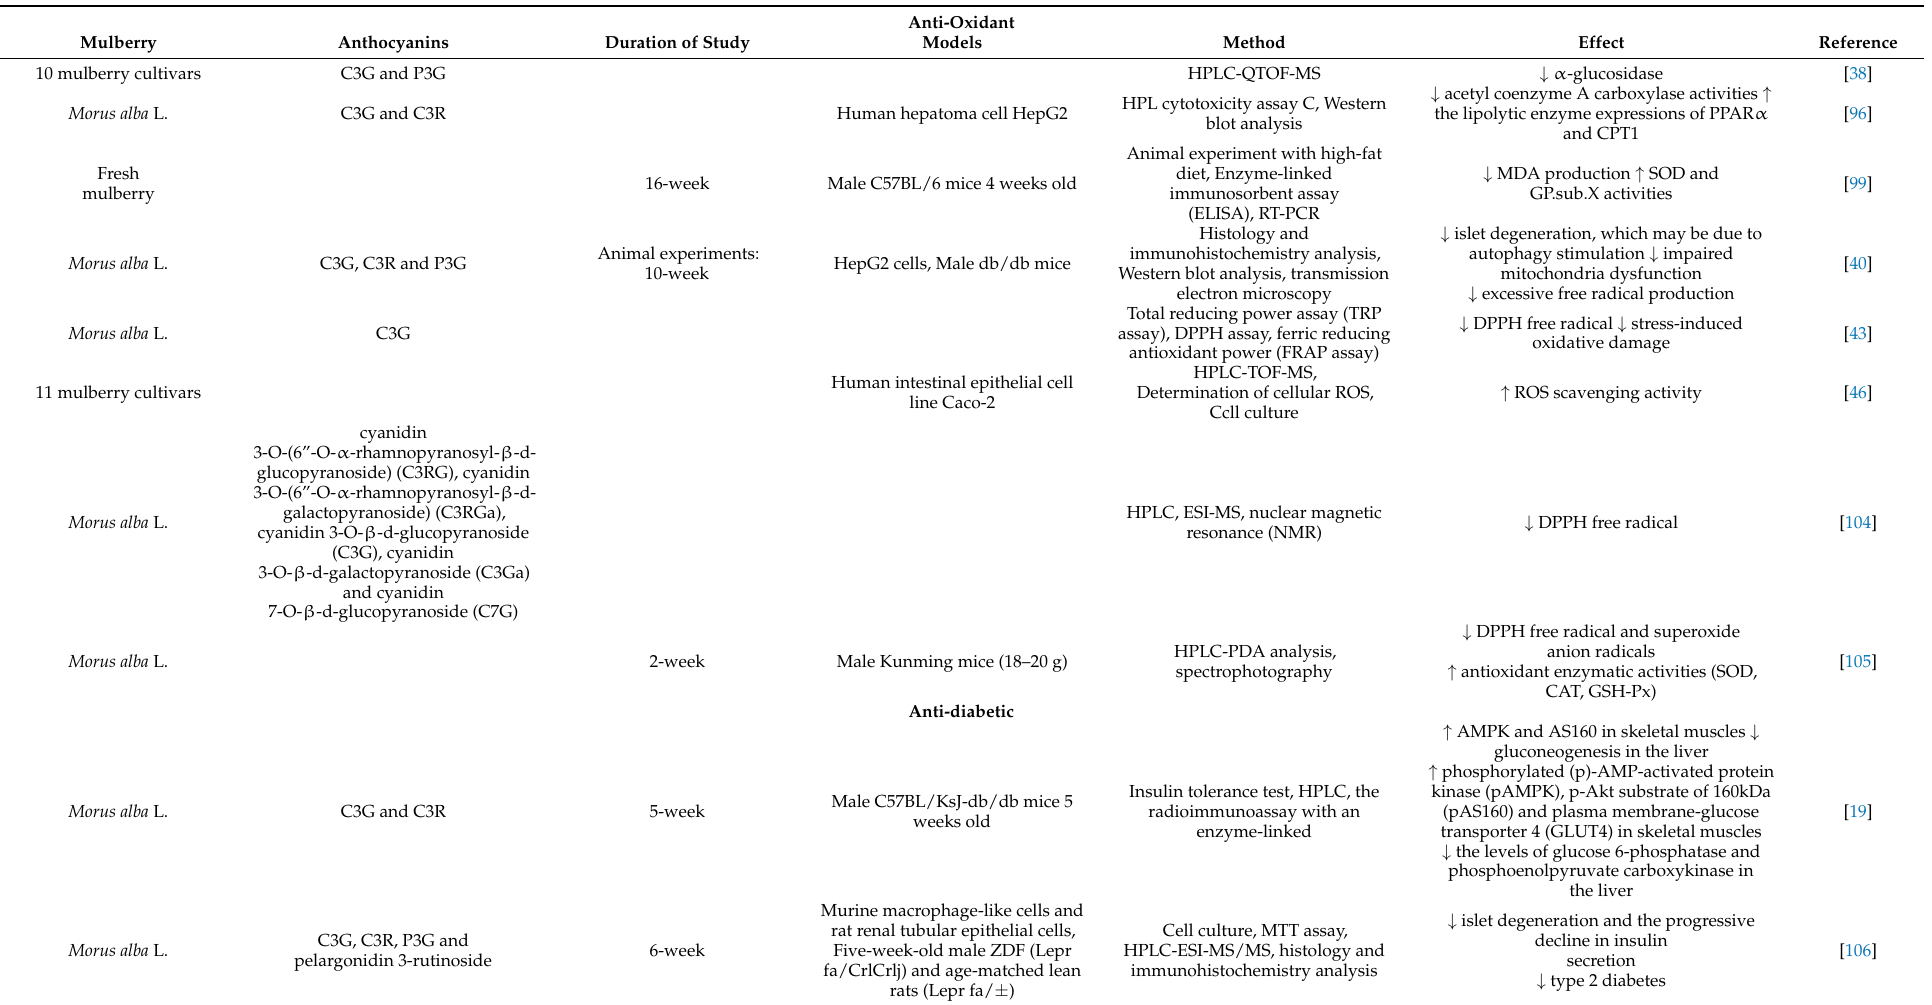
Table 3. The healthy effects of anthocyanins in